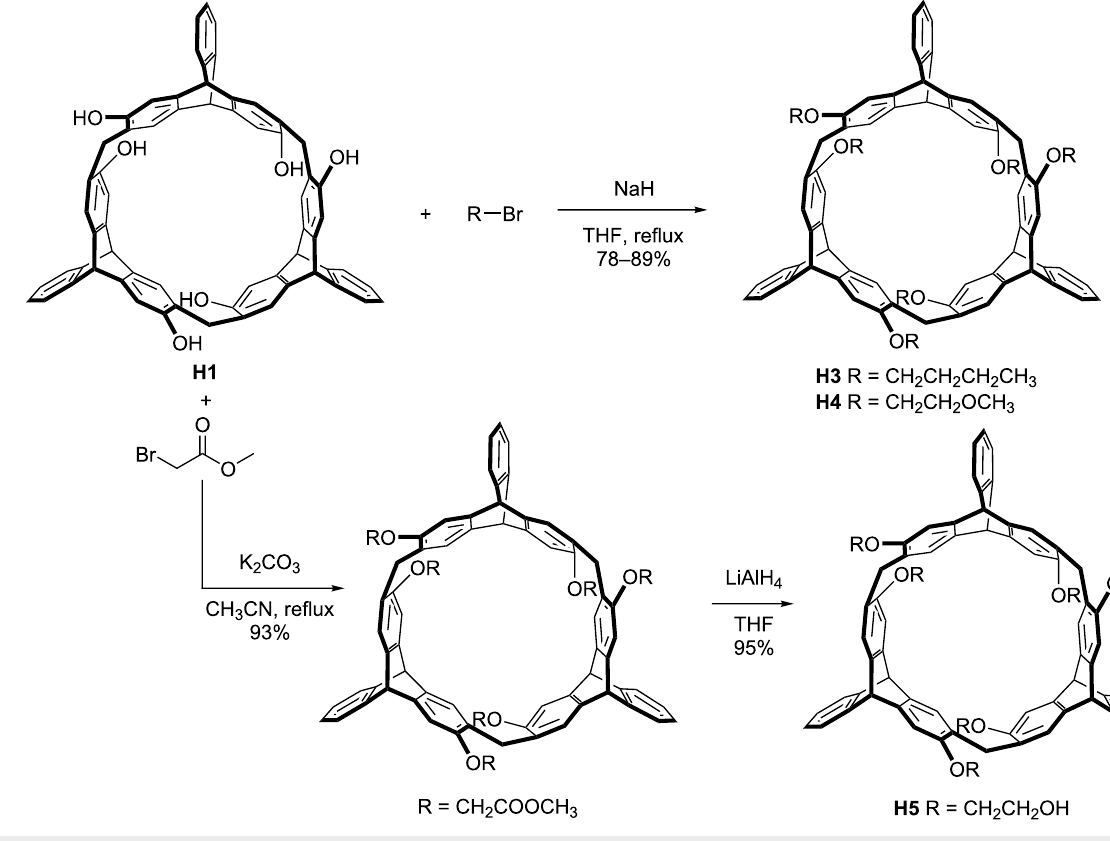
Scheme 1: Synthesis of hosts H3 – 5 .